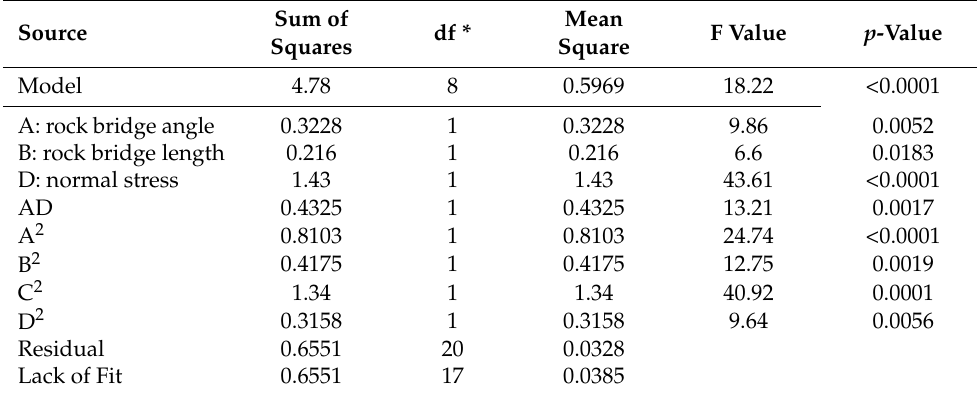
Table 8. ANOVA for response surface quadratic model for shear